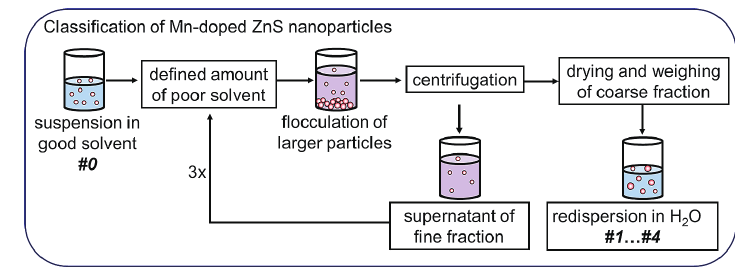
Fig. 10 Illustration of the experimental procedure of SSP. With kind permission from Springer Science+Business Media: Segets et al., “Quantitative evaluation of size selective precipitation of Mn-doped ZnS quantum dots by size distributions calculated from UV/Vis absorbance spectra” J. Nanopart. Res. 2013 15:1486, Scheme